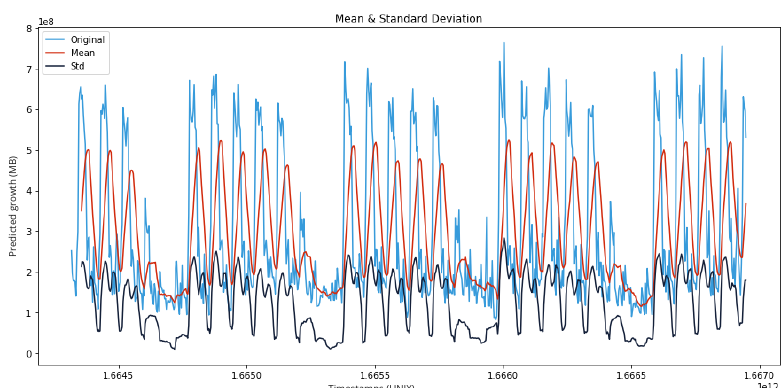
Figure 22. The prediction of the mean and standard deviation.